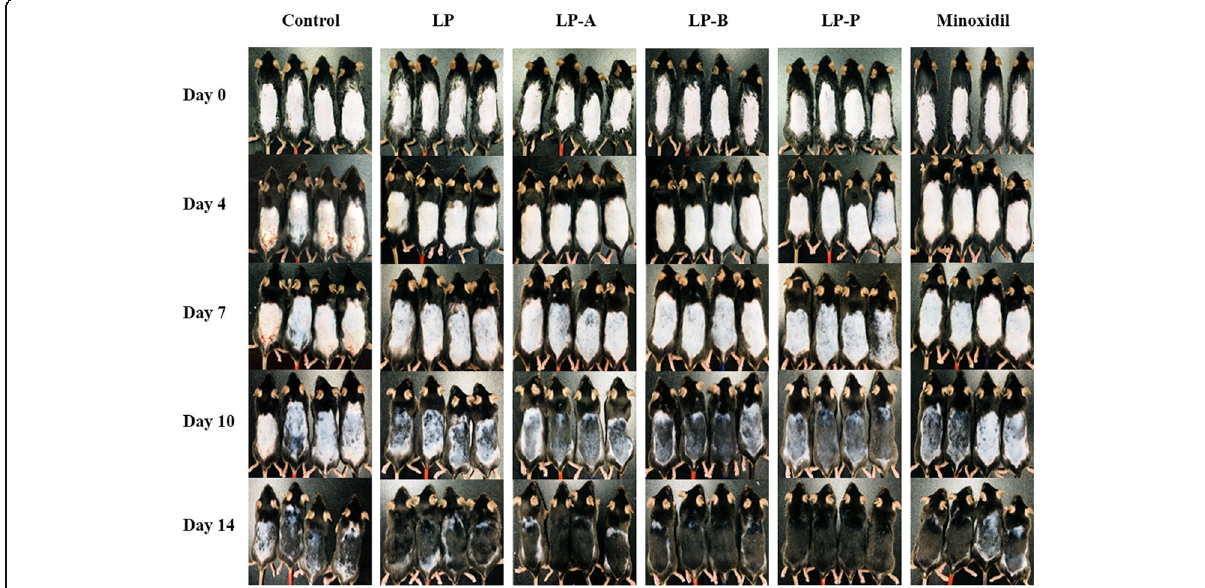
Fig. 4 Photograph of hair growth in C57BL/6 mice. The animals were shaved with an electric clipper and the sample applied with 0.1 mL per to the dorsal skin of mice for 2 weeks. The photographs were taken at days 0, 4, 7, 10, and 14. Con: distilled